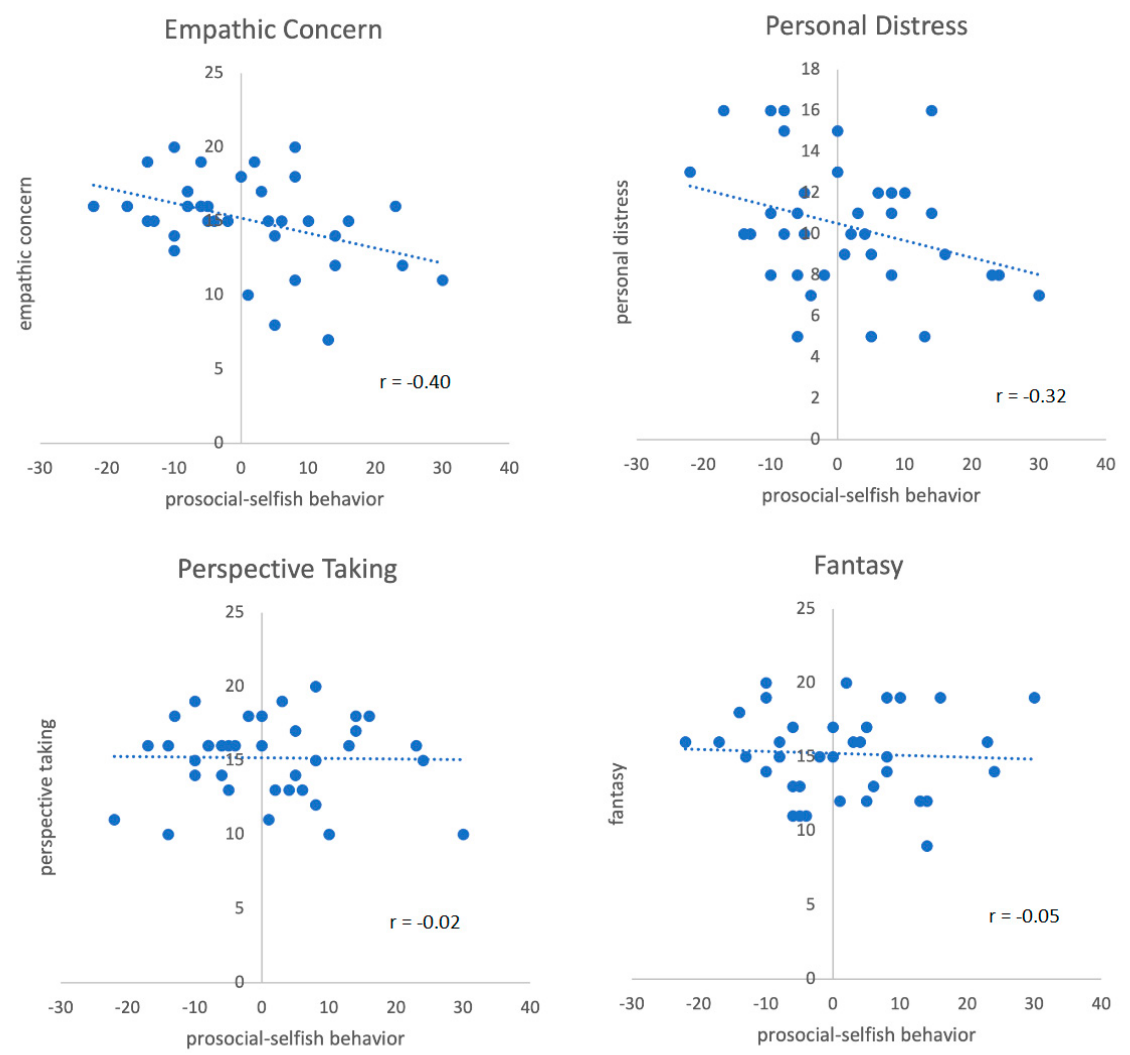
Figure 2. Scatterplots of behavioral responses (prosocial minus selfish decisions) and empathy subscales (Pearson correla- tions). The figure demonstrates that individuals with high affective empathy (empathic concern and personal distress) tend to be less prosocial in the DG. Cognitive empathy (perspective taking and fantasy) was not related to prosocial behavior.